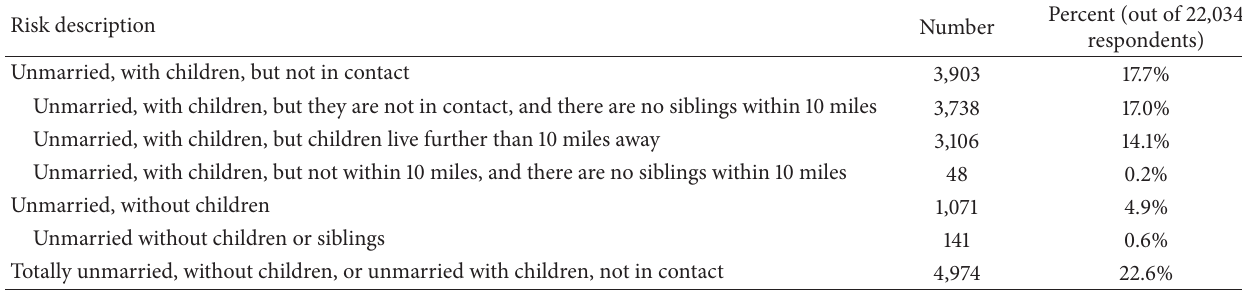
Table 2: The table shows the prevalence of those at risk of becoming an elder orphan based on 2010 data. Prevalence was calculated by dividing the sum of the total individuals in the “unmarried, with children, but not in contact” tier and the “unmarried, without children” tier (the two biggest risk factors for becoming an elder orphan ) by the total of respondents to the health and retirement study [4]. Risk description Unmarried, with children, but not in contact Unmarried, with children, but they are not in contact, and there are no siblings within 10 miles Unmarried, with children, but children live further than 10 miles away Unmarried, with children, but not within 10 miles, and there are no siblings within 10 miles Unmarried, without children Unmarried without children or siblings Totally unmarried, without children, or unmarried with children, not in